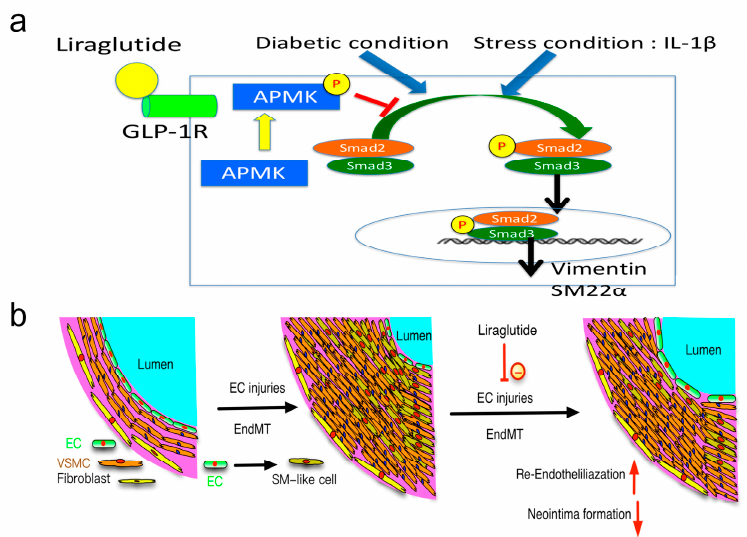
Figure 8. Liraglutide attenuates diabetes-associated neointima formation and pathogenic EndMT via the AMPK pathway. ( a ) The proposed underlying mechanisms of the therapeutic effects of liraglutide on the attenuation of a diabetes-associated vascular injury. Upon diabetic conditions such as hyperglycaemia in combination with pro-inflammatory stimulation by IL-1 β , endothelial cells undergo the pathogenic EndMT process with increased mesenchymal marker expression (vimentin and SM22 α ). Liraglutide, a GLP-1 agonist, activates downstream AMPK signaling via GLP-1R and attenuates diabetic insult-induced EndMT in endothelial cells. ( b ) In vivo, endothelium-derived smooth muscle-like cells contribute to the progression of neointima formation after a wire-induced carotid artery injury. Reduced neointima formation in diabetic mice upon liraglutide treatment may be partially attributed to the reduced EndMT process.